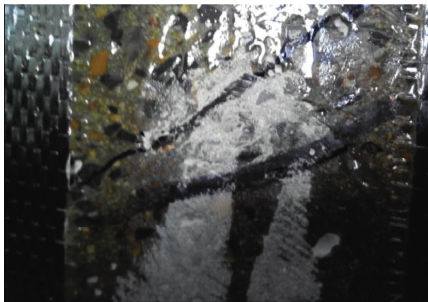
Figure 20: The cracks under the 1.2 million fatigue load test. Table 11: The relation between deflections and strain and fatigue loading times for carbon-fiber-reinforced plate under the 200kN load.